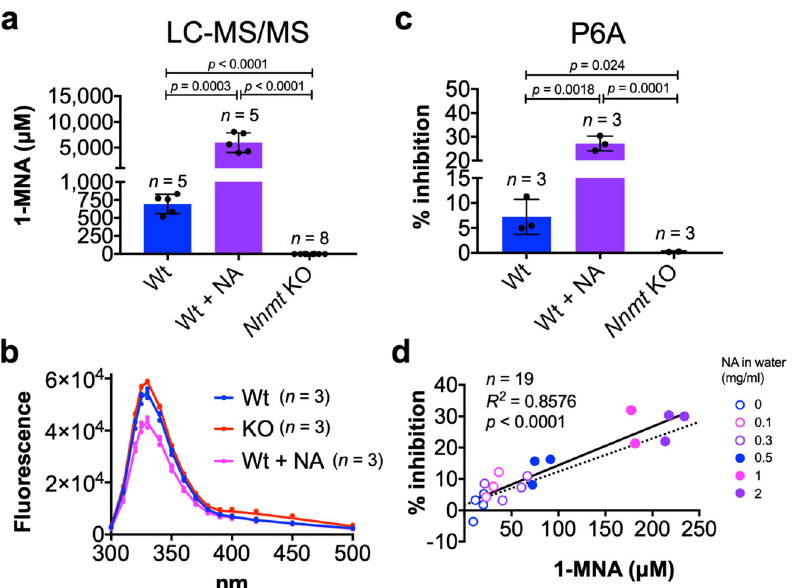
Fig. 6 P6A speci fi cally and quantitatively detects urinary 1-MNA. a Concentration of urinary 1-MNA quanti fi ed by LC-MS/MS. b Fluorescence spectra of